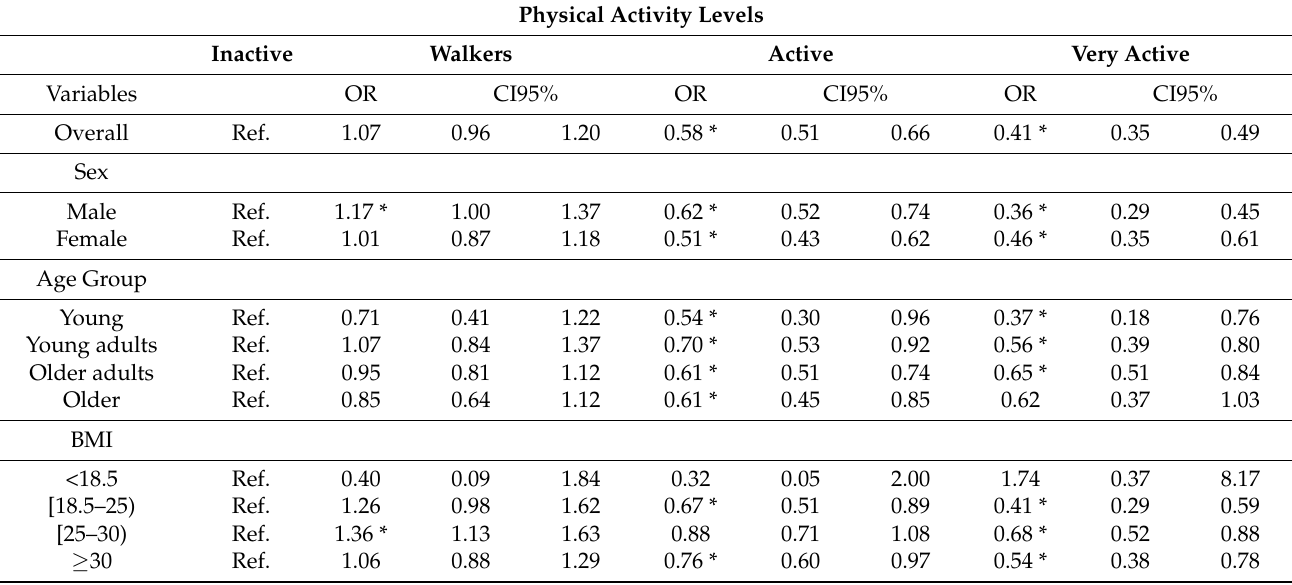
Table 6. Risks of hypertension, according to level of physical activity.